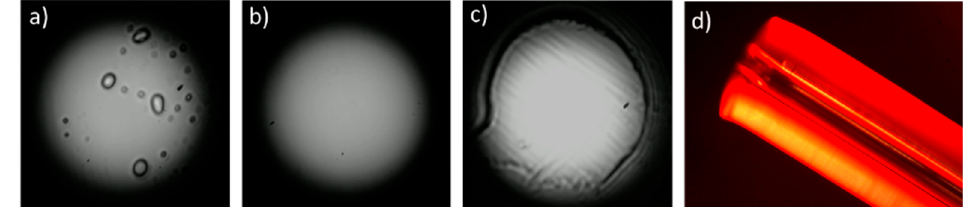
Figure 11. Demonstration of different kinds of the near-field intensity pattern imperfections: ( a ) presence of cleaving product (dust and pieces of material) ( b ) that can be removed by end-face cleaning; ( c ) exfoliation in the proximity of the core-cladding boundary; ( d ) the CYTOP core-cladding structure shift in relation to the protective cladding.